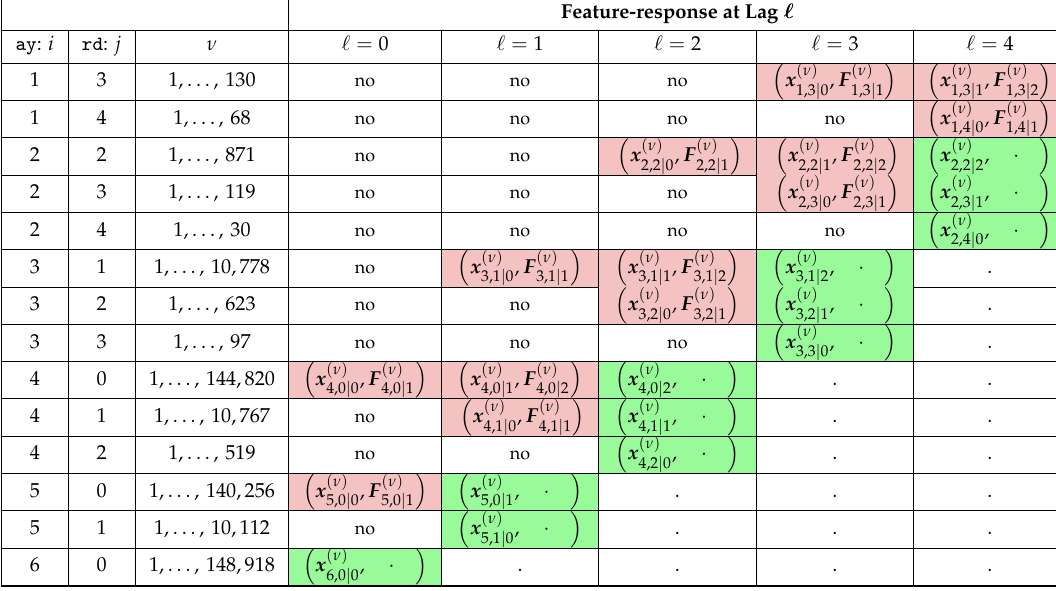
Table 4. Pairs feature-response organized by lag relevant for prediction at time I = 6 in the considered claims